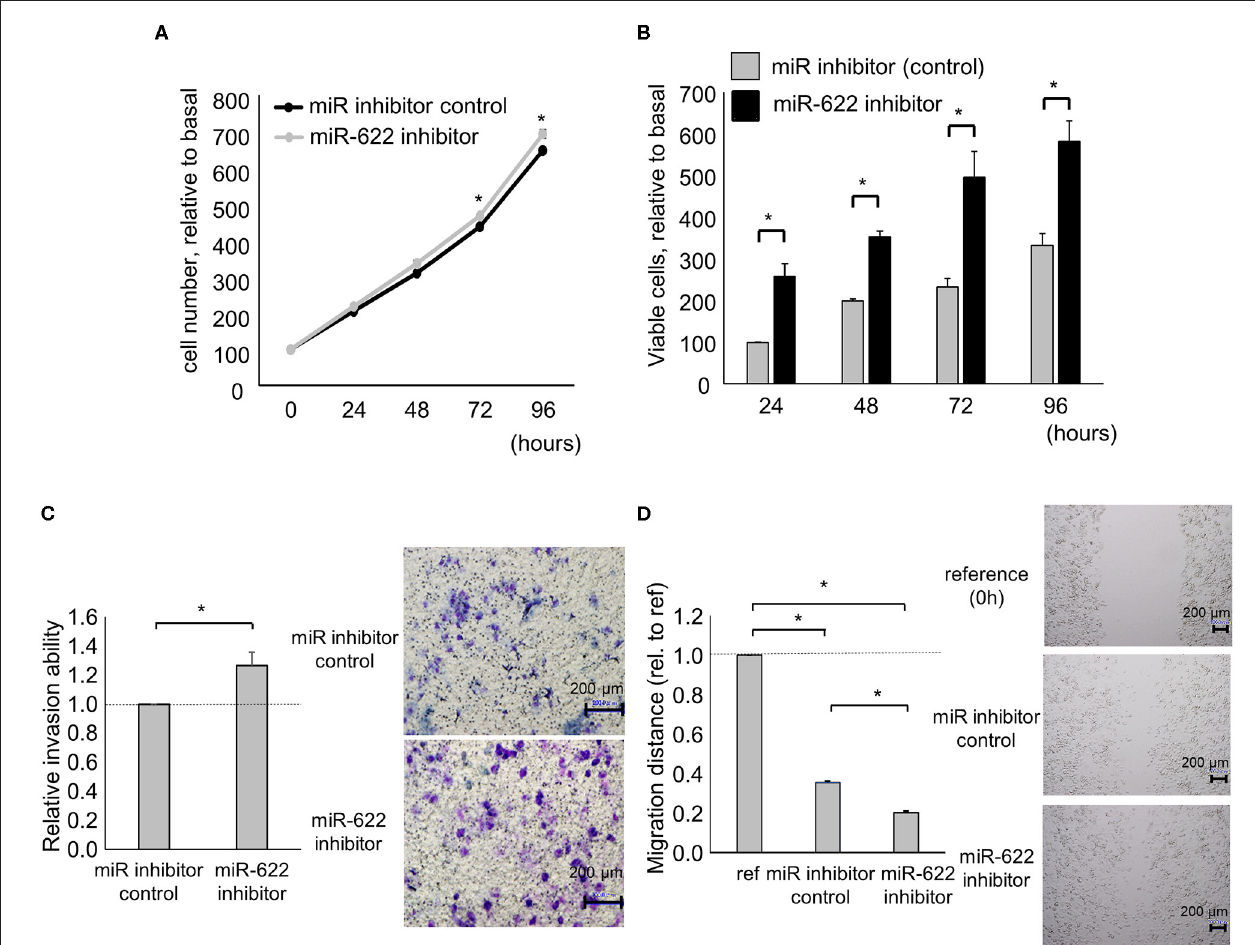
FIGURE 5 | Effect of miR-622 inhibition on the phenotype of PDAC cells. Panc-1 cells were transfected with 12.5nM miR-622 or a control inhibitor. (A,B) After 24, 48, 72, and 96h, cell proliferation was assessed by cell counting using trypan blue (A) and cell viability was investigated by MTS assay (B) . (C) After 24h, cell invasion was examined by Transwell assay using an inverted microscope. (D) After 24h, cell migration was examined by wound healing assay. Reference indicates the image at time 0. Bars are the means ± SEM of three independent experiments. * P <